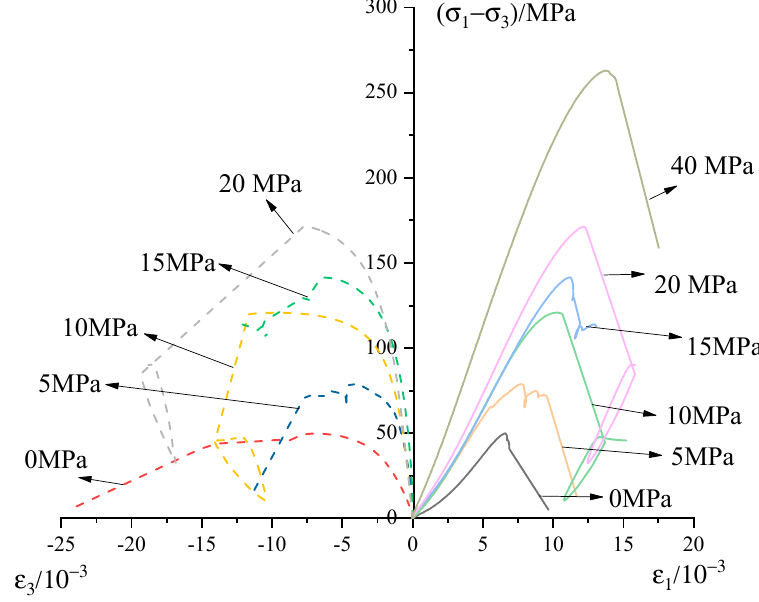
ff erent confining